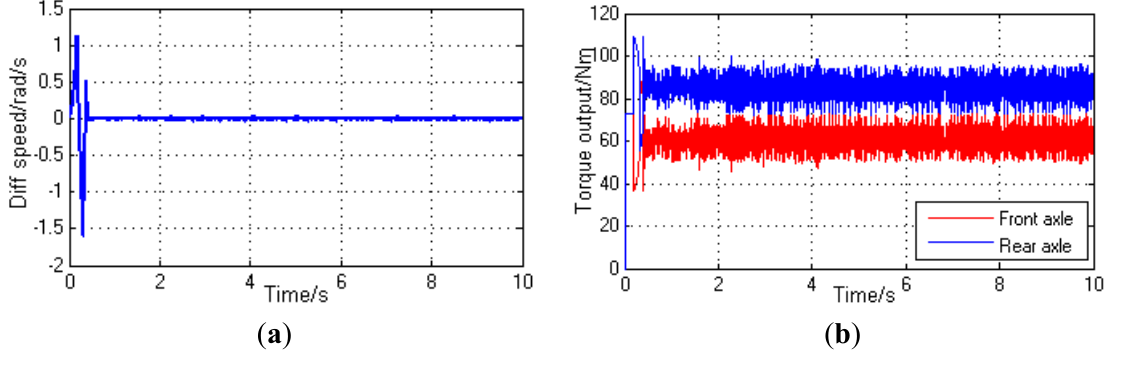
Figure 8. The change of sliding mode surface and controlled variables in the sliding mode control process: ( a ) Convergence process of the front and rear axle speed deviation; ( b ) Output torque of the front and rear axle motor under sliding mode control.